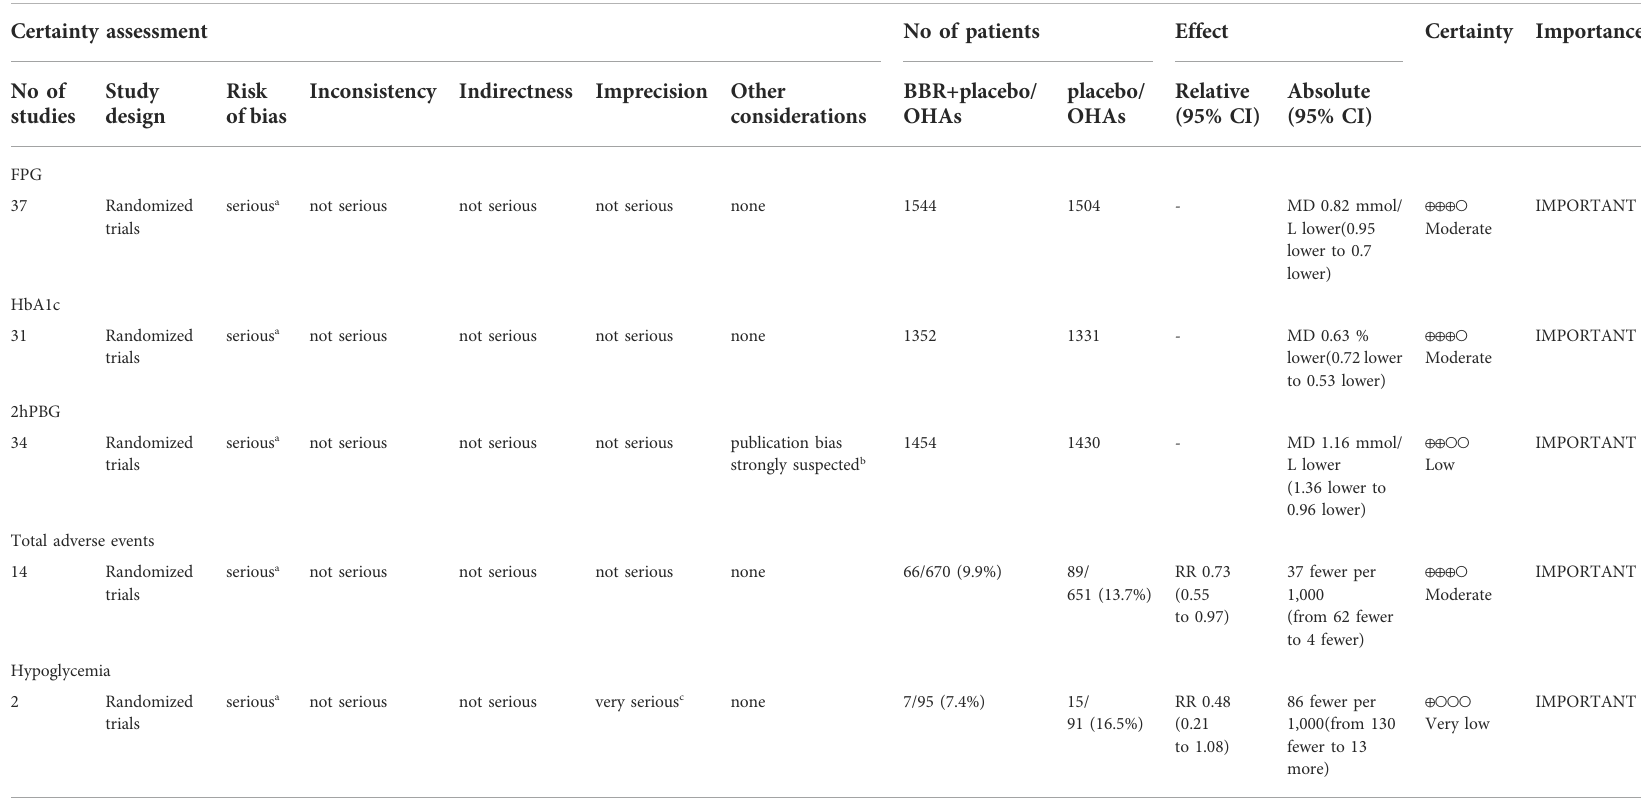
TABLE 6 Summary of fi ndings